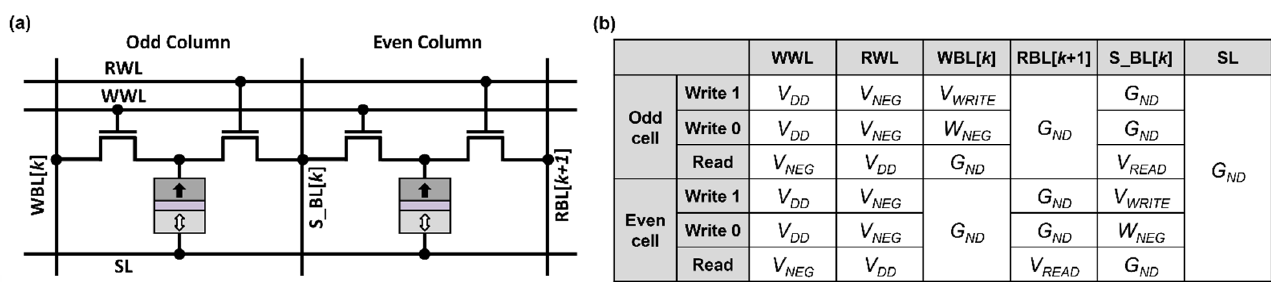
Figure 5. ( a ) Proposed 1R/1W STT-MRAM bit-cell schematic and ( b ) biasing condition for write and read operations.